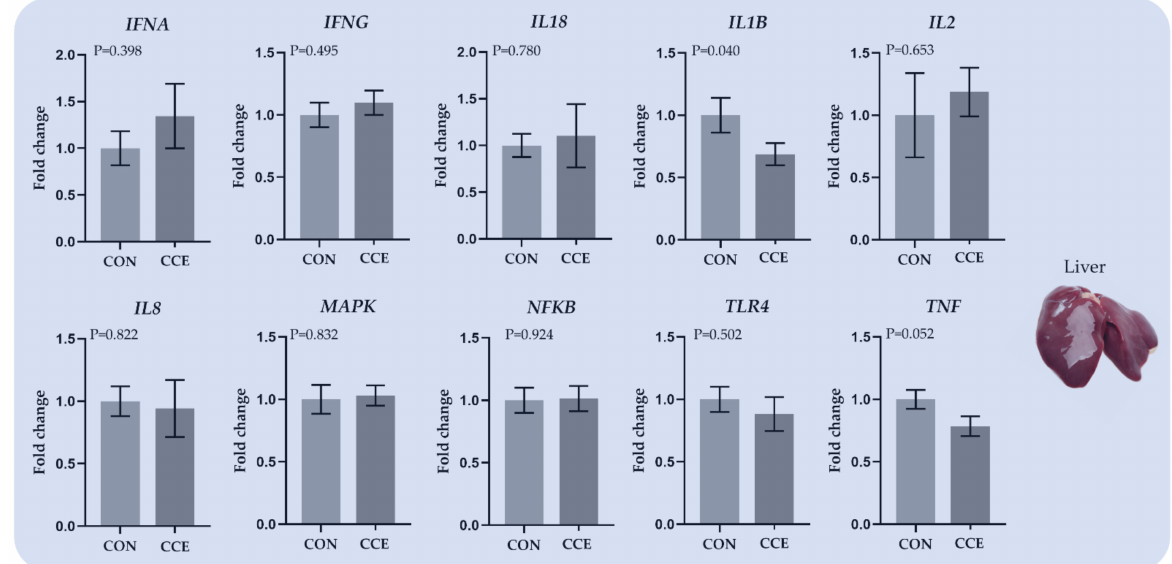
Figure 6. The mean and standard error of means (SEM) of relative transcript levels as fold changes of several genes involved in the immune system in the liver of broilers fed the two experimental diets (Control; CON and carotenoid extract from Citrus reticulata included in soluble starch; CCE) at 42 days. INFA: Translation initiation factor IF-1, INFG: Interferon-gamma, IL18: Interleukin 18, IL1B: Interleukin 1 Beta, IL2: Interleukin 2, IL8: C-X-C Motif Chemokine Ligand 8, MAPK: Mitogen-activated protein kinase, NFKB: Nuclear factor-kappa B, TLR4: Toll-like receptors 4, and TNF: Tumor necrosis factor .